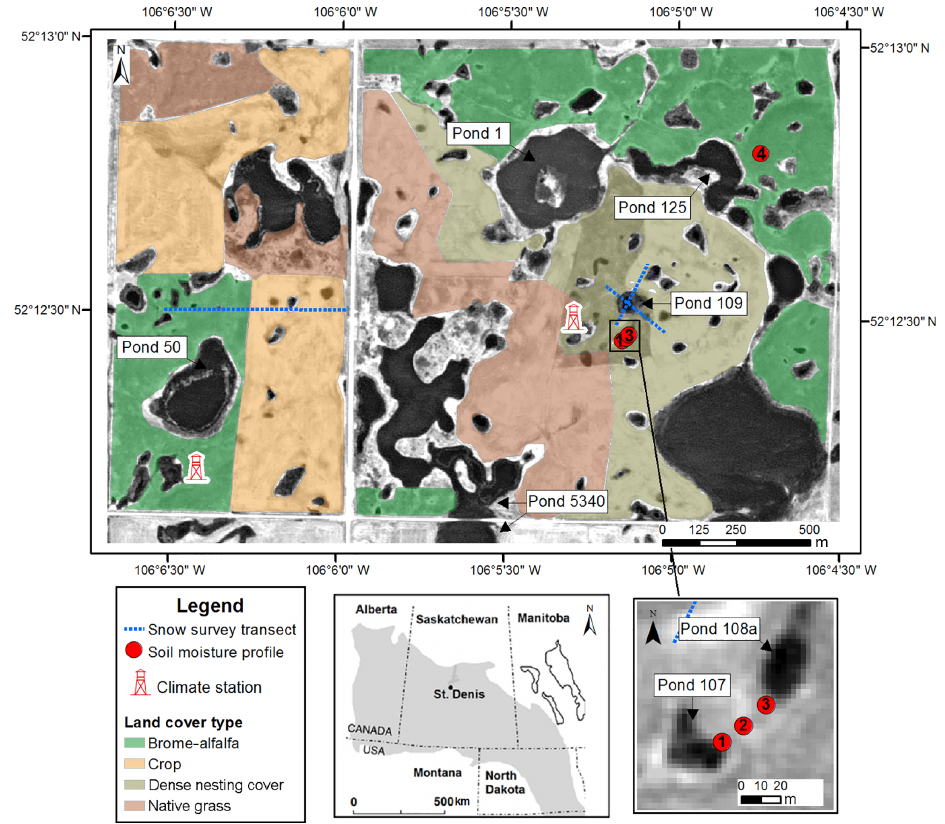
Figure 1. Map and location of St. Denis National Wildlife Area. The grey area on the inset map represents the extent of Prairie Pothole Region in North America.